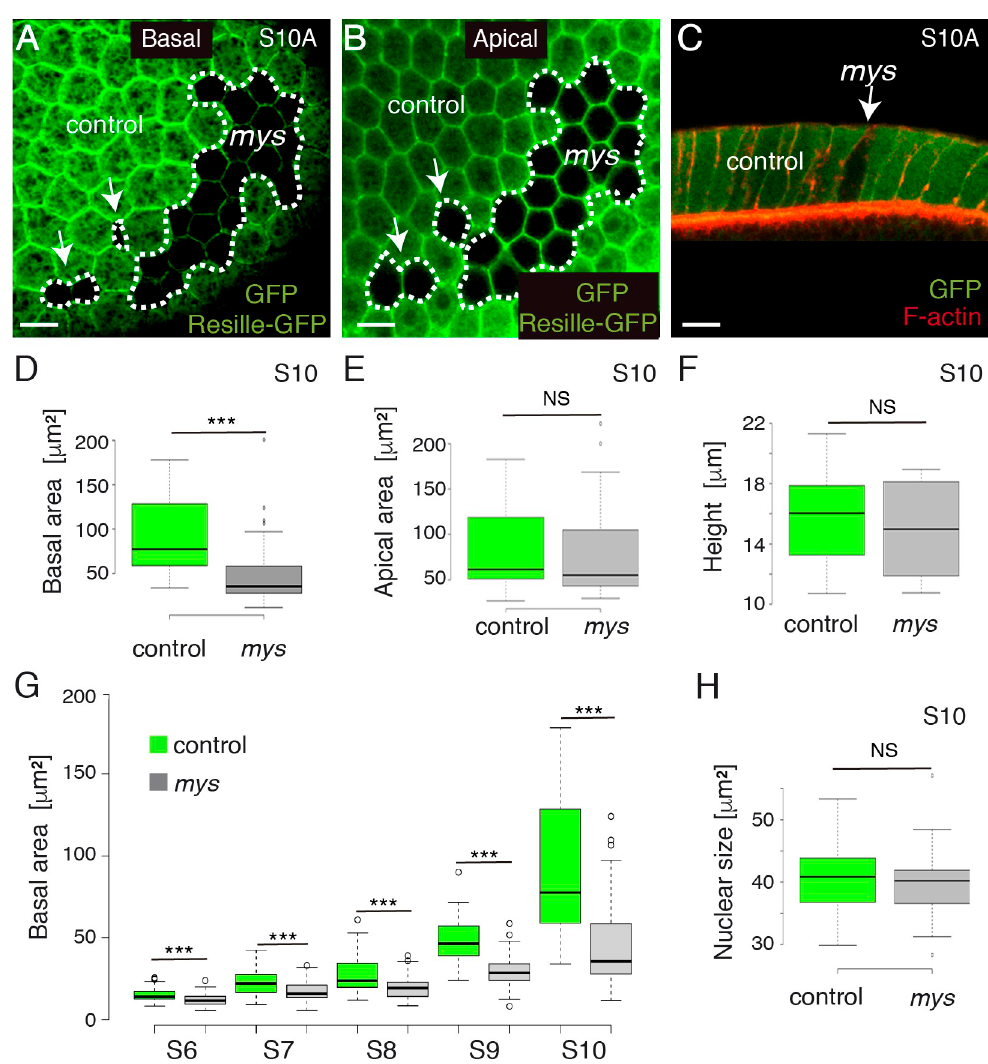
Fig 4. mys mutant FCs show defective basal surface expansion. Basal (A) and apical (B) surface views of a S10A mosaic egg chamber containing mys FC clones (GFP-negative) and expressing the cell membrane marker Resille-GFP, stained with anti-GFP. (C) Lateral view of a mosaic FE stained with anti-GFP (green) and Rodamine Phalloidin to detect F-actin (red). (D, E, F) Box plots of the basal surface (D), apical surface (E) and height (F) of control (green) and mys (grey) S10 FCs. (G) Box plot of the basal area of control (green) and mys (grey) FCs at different stages of oogenesis. ( H ). Box plot of the nuclear size of control (green) and mys (grey) S10 FCs. The statistical significance of differences was assessed with a t-test, ��� P value < 0.0001. Scale bars, 10 μ